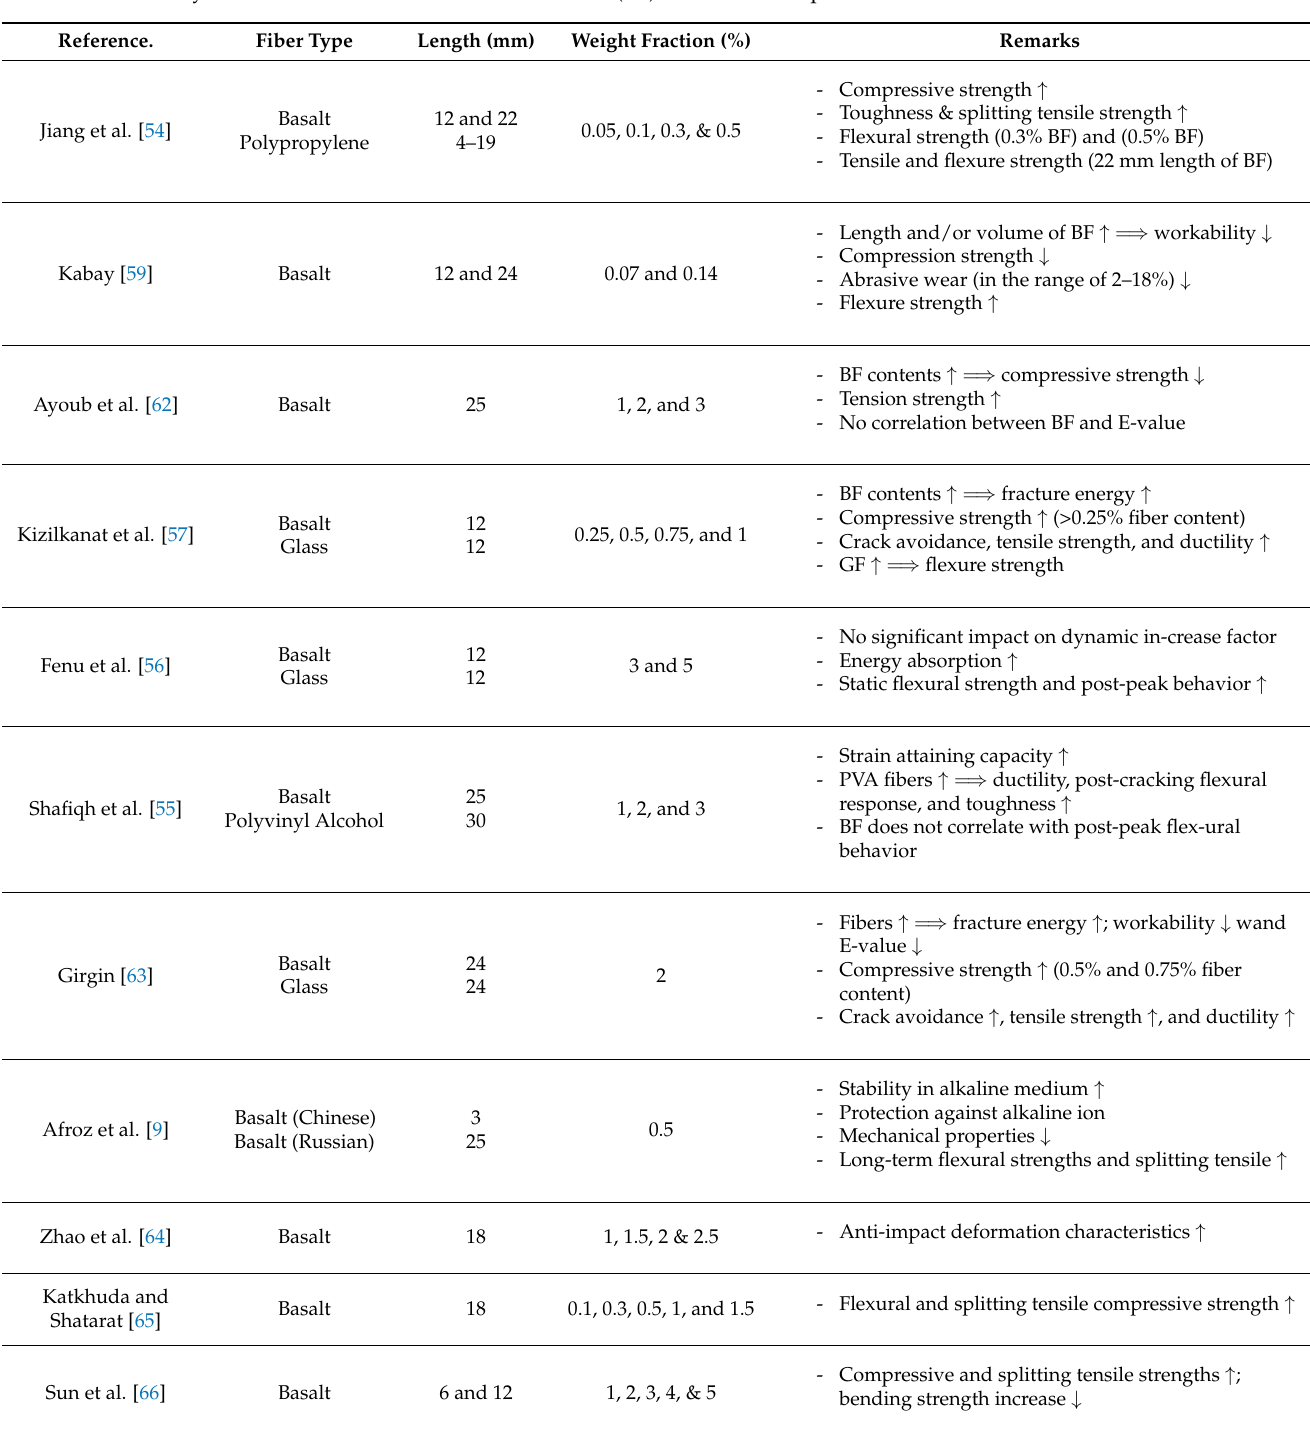
Table 2. A summary of the studies on the effect of basalt fiber (BF) on mechanical parameters of concrete.